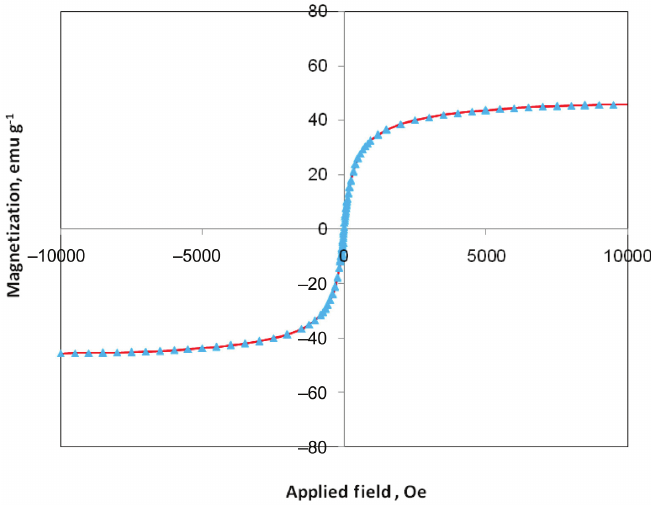
Fig. 6 – Magnetization curve of MHN adsorbent at 298